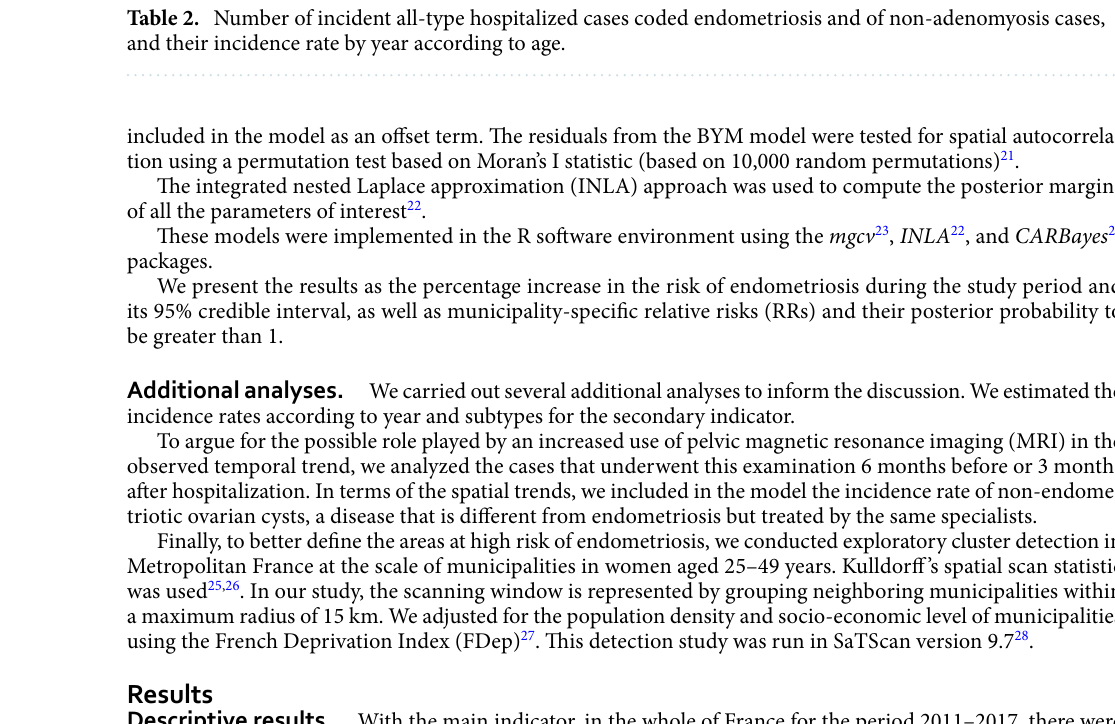
Table 2. Number of incident all-type hospitalized cases coded endometriosis and of non-adenomyosis cases, and their incidence rate by year according to age.